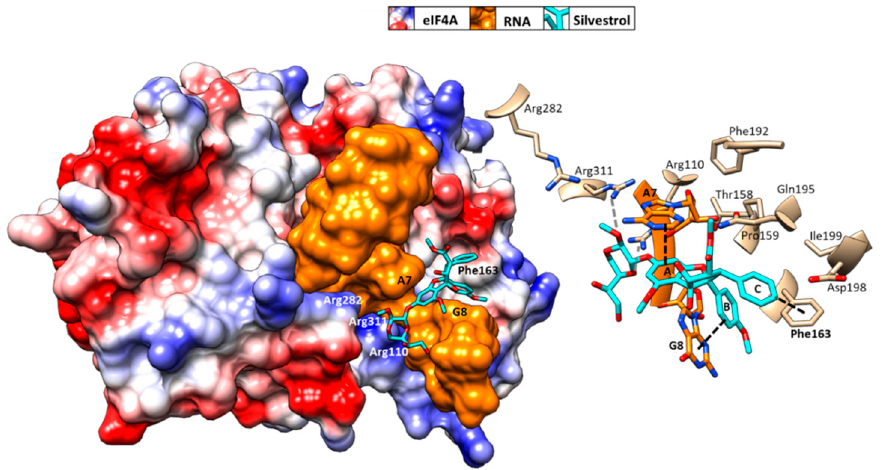
Figure 5. Predicted binding mode of silvestrol using structure-based computational modeling of silvestrol onto the eIF4A–RNA complex (PDB: 5ZC9). The dioxane moiety of silvestrol has the potential to form additional contacts with arginine residues on the surface of eIF4A and may thus bridge over the RNA substrate to tightly clamp the RNA onto eIF4A [83]. UCSF (University of California, San Francisco) Chimera was used for graphical illustration and electrostatic surface coloring of eIF4A (blue: positive charged, red: negative charged).